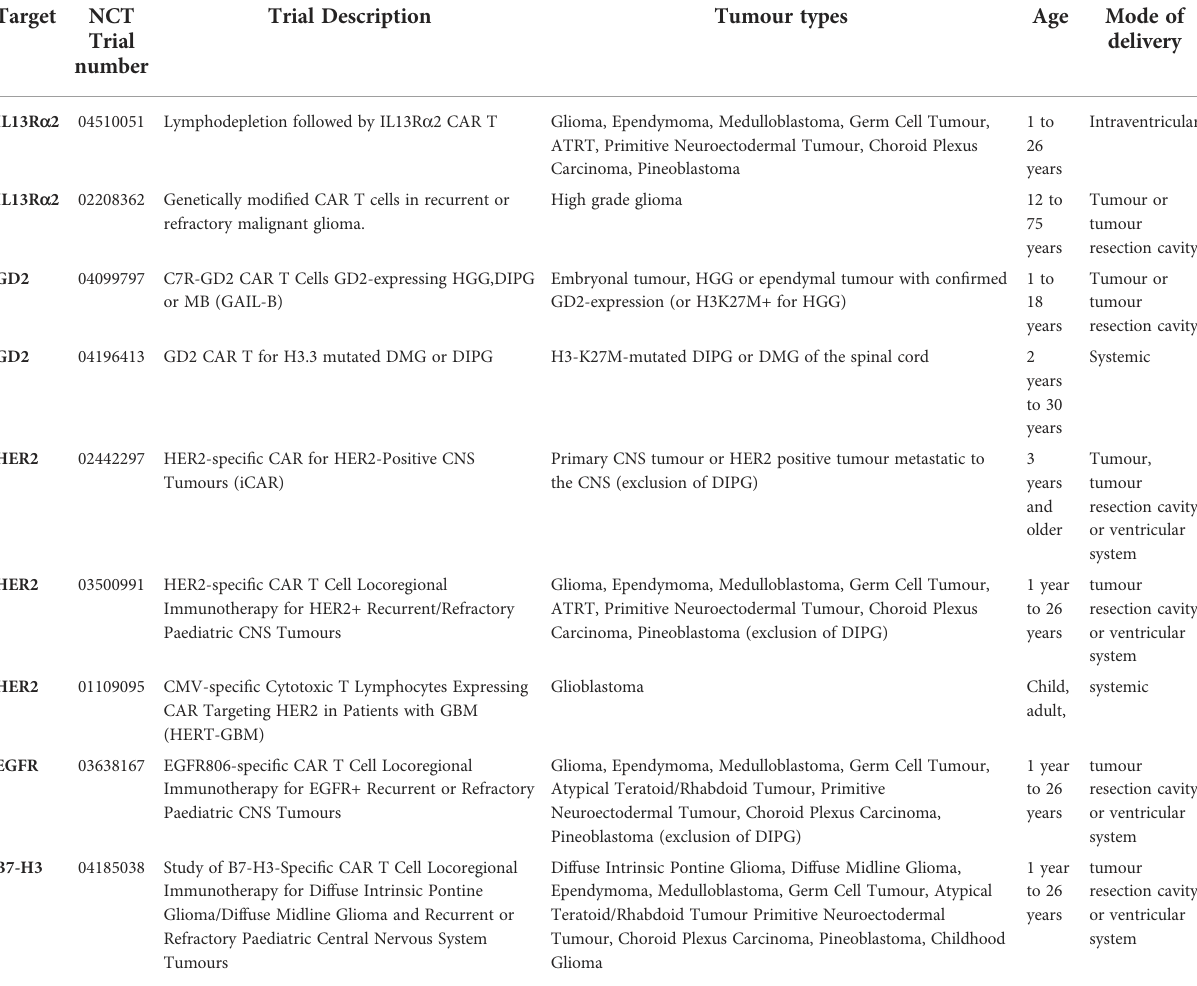
Table data were searched at clinicaltrials.gov (21 st June